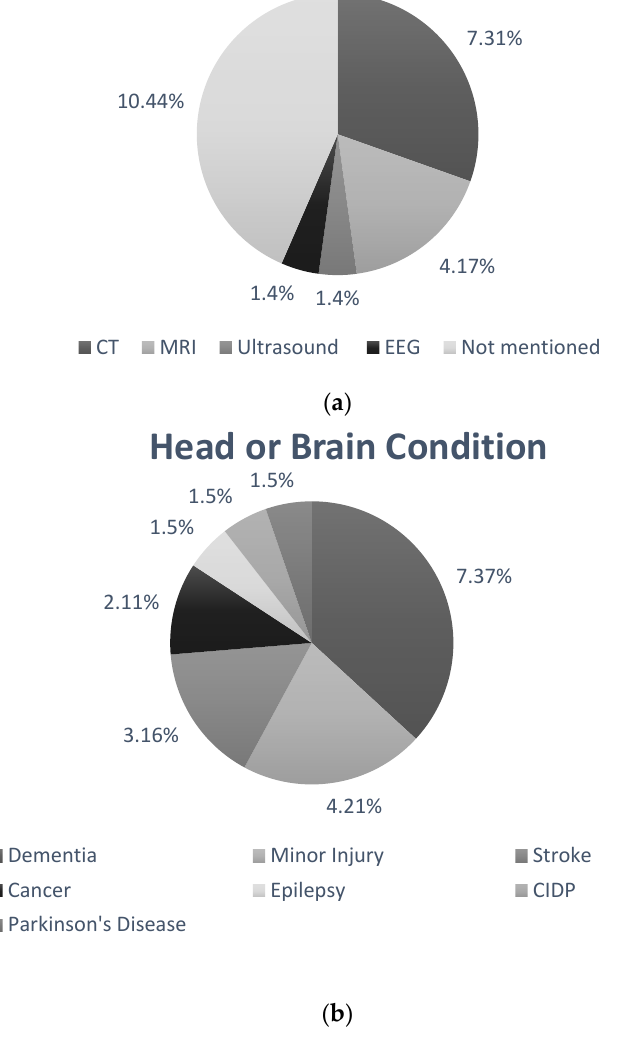
Figure 2. Pie charts representing the distribution of data collected. ( a ) This pie chart represents the distribution of data collected on neuroimaging techniques. Approximately 31% of studies reported on CT imaging techniques, 44% of studies did not mention imaging directly and ultrasound and EEG were only mentioned in one study each. This shows that there are not enough data available on ultrasound and EEG imaging and this should be considered for an area of further research. ( b ) This pie chart represents the distribution of data collected on neurological conditions. Approximately 37% of the studies presented data for dementia, showing that there is more research available on the health inequalities in dementia, while only one study reported on the accessibility of ultrasound and EEG